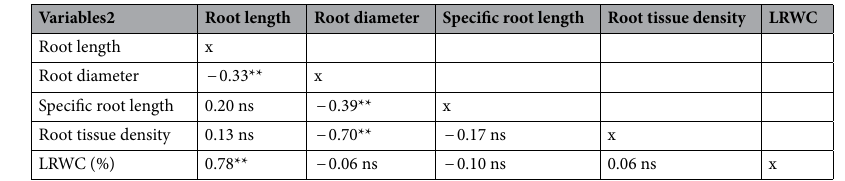
Table 4. Correlations between eucalyptus root architecture and leaf relative water content. **and ns significant at P ≤ 0.01 and non-significant probability levels, respectively.